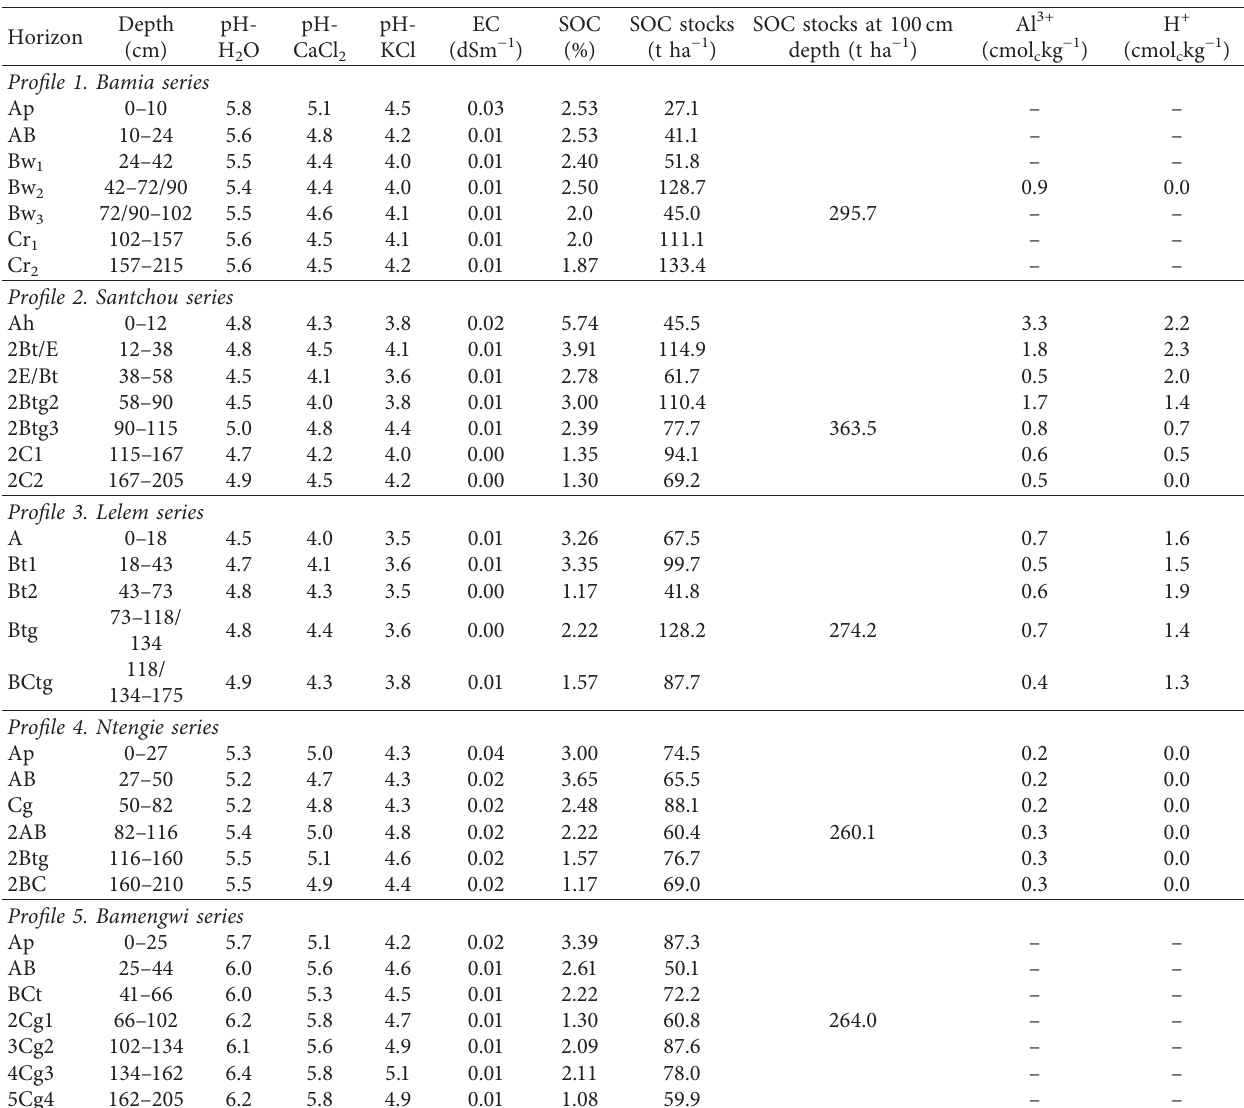
Table 5: Chemical properties and SOC